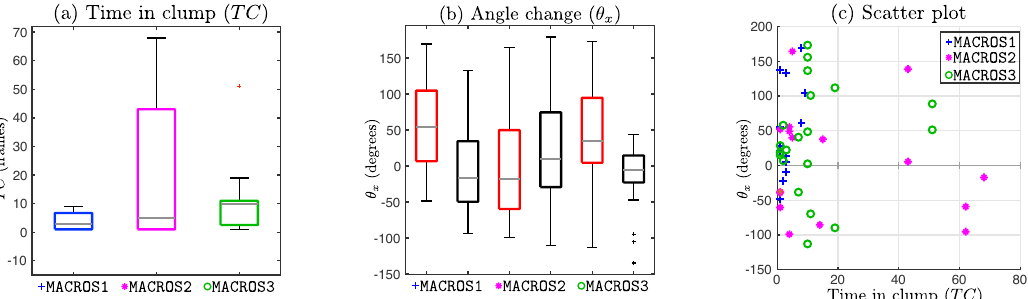
Figure 11. Comparison of the time in clump and the angle of variation. ( a ) Boxplot diagram comparing time in clump ( TC ) per dataset; ( b ) Boxplot comparing the value of the measured angle change from the contact (red) and the control (black) experiments; ( c ) Scatter plot of time in clump vs. angle change in contact experiments per dataset.